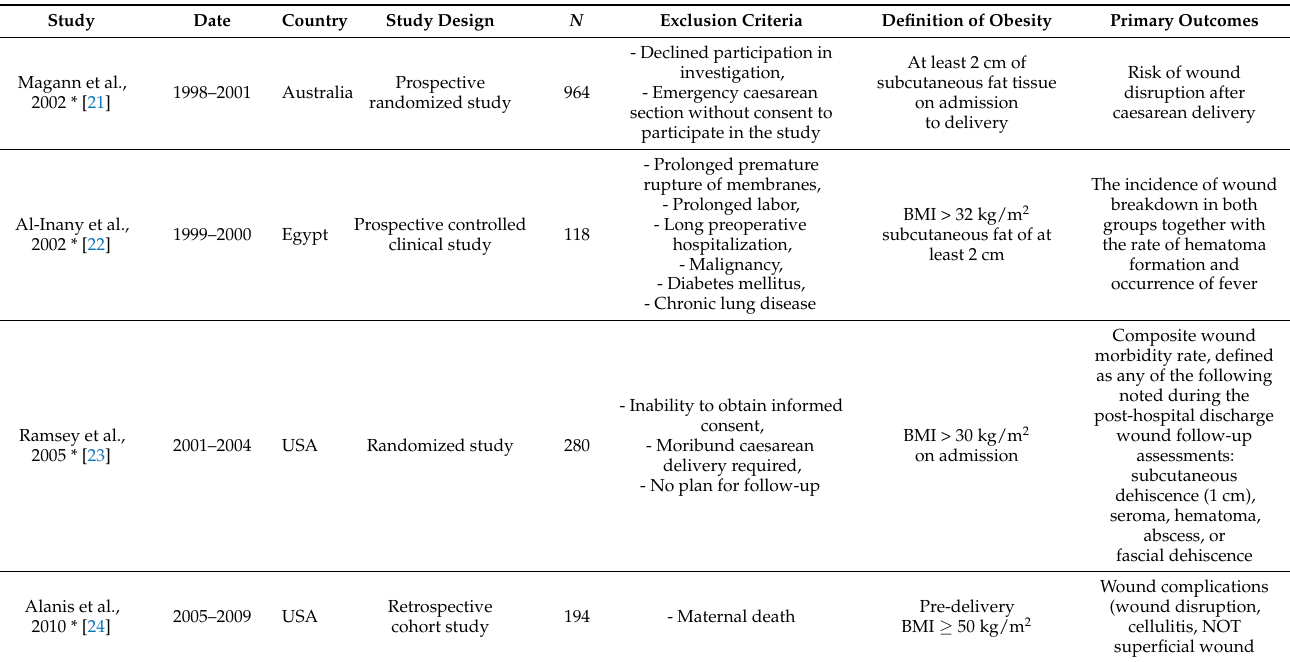
Table 1. Characteristics of studies included in the systematic review and